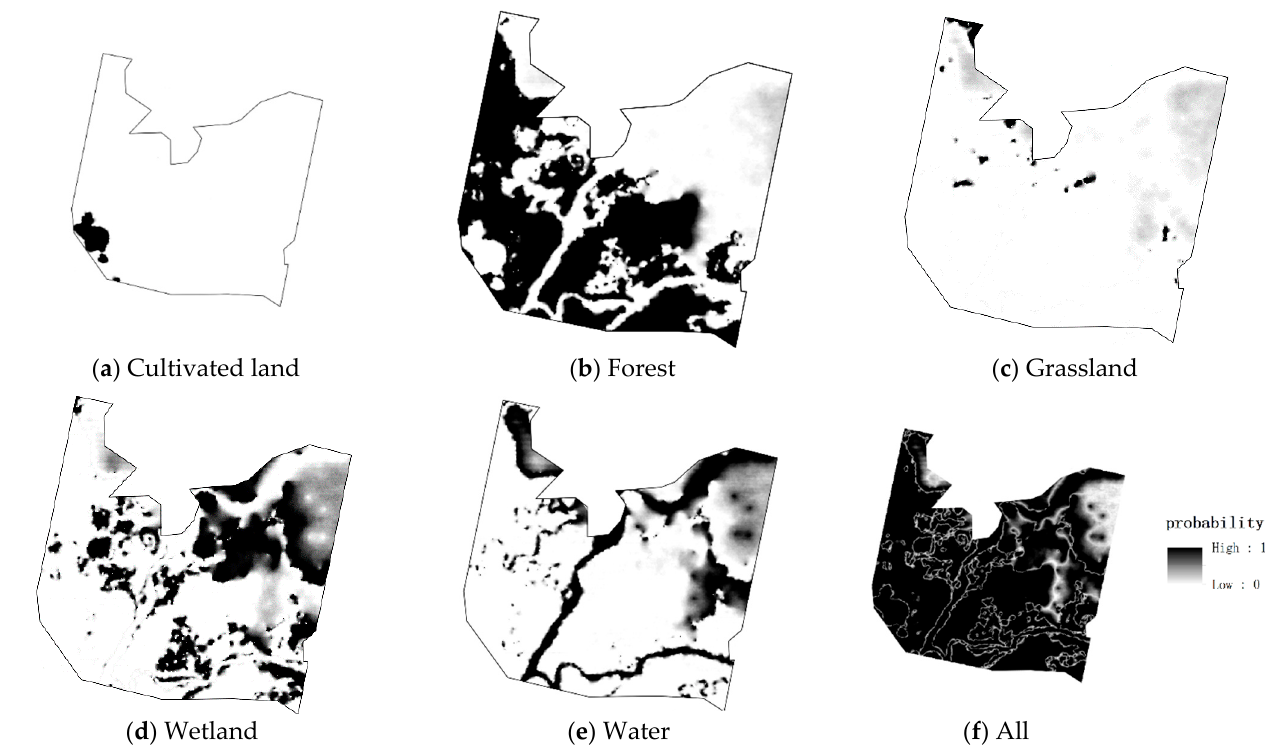
Figure 6. Occurrence probability map results of using sample points. The optimal prediction map of the simulation results is shown in Figure 7, which